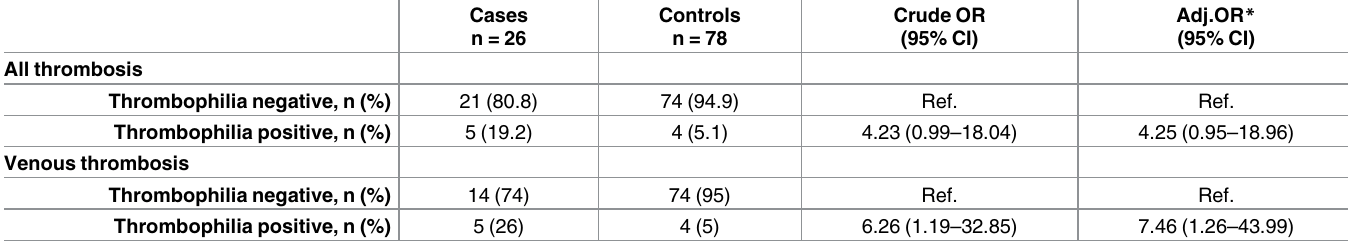
Table 4. Association between thrombophilia (heterozygous factor V Leiden or prothrombin G20210Amutation) in the recipients and the risk of thrombosis after liver